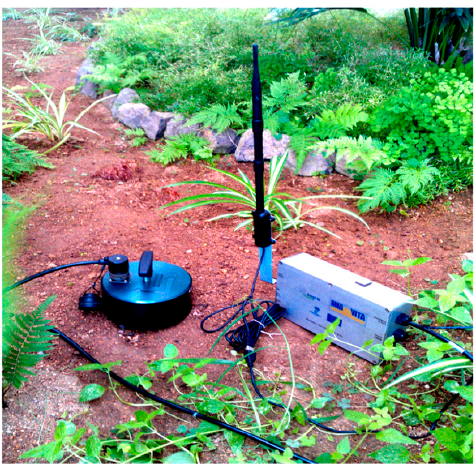
Figure 11. A depiction of a geophone sensor with a wireless antenna deployed in the field [23]. Forest Fire Prevention